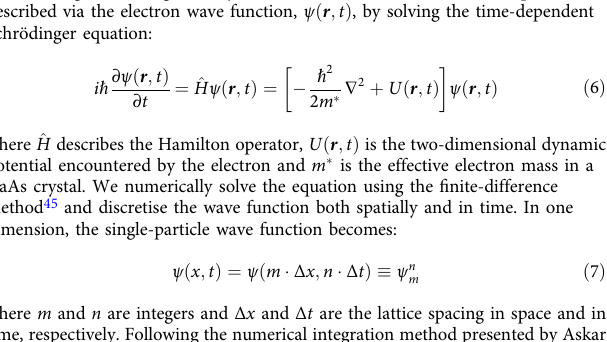
Coulomb-blockade peaks to deduce the amplitude of the SAW modulation, A , in energy. Figure 6b shows an exemplary data set showing the broadening of Coulomb-blockade peaks with increasing transducer power, P . Attentuation along